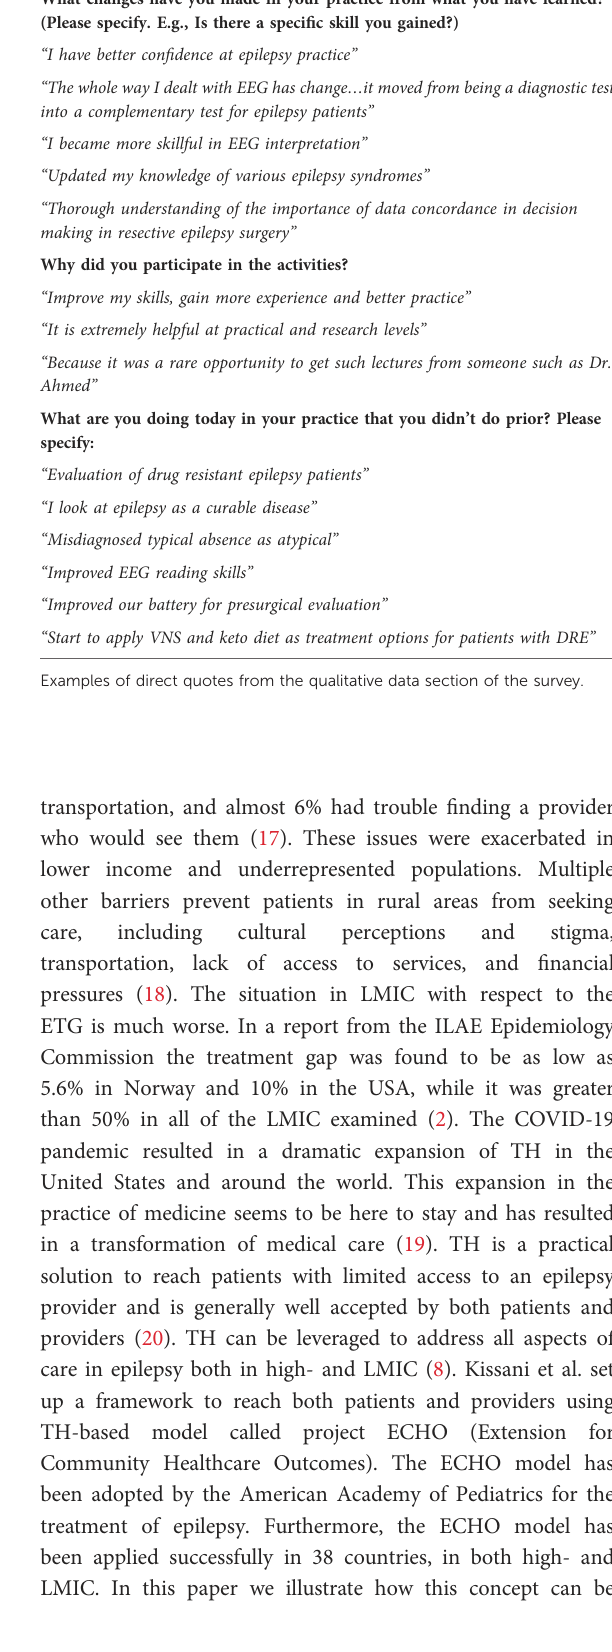
TABLE 6 Egypt provider demographics. TABLE 7 Qualitative data quotes from providers in